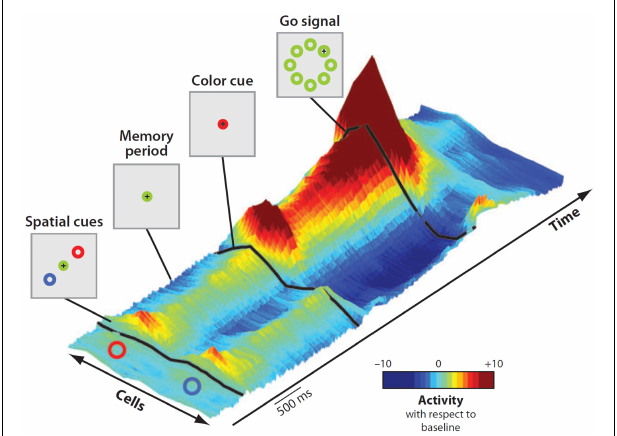
FIGURE 5 |Time course of population activity in the dorsal premotor cortex during a reach-selection task. The diagrams on the left replicate the temporal sequence of the visual displays during the task. Each trial began with the monkeys moving the cursor ( + ) into a central green circle. Next, a red and a blue cue circle appeared at two of eight possible target positions, in opposite directions from the center for about a second (first display, “Spatial cues”).Then the cues disappeared (second display, “Memory period”) and after a variable period the central circle changed color to red or blue (third display, “Color cue”). Finally, the go signal was delivered (fourth display).The central circle disappeared and green circles appeared at all eight positions.To perform correctly the monkeys had to move the cursor from the central circle to the target indicated by the color cue.The 3-D colored surface on the right depicts changes of neural activity along time with respect to baseline, with cells sorted by their preferred direction along the bottom edge. Note that during the entire period of ambiguity until the presentation of the color cue, the population encoded both potential directions.When the color cue provided the information for selecting the correct action, its neural representation was strengthened while the other was suppressed. Reproduced with permission from Cisek and Kalaska